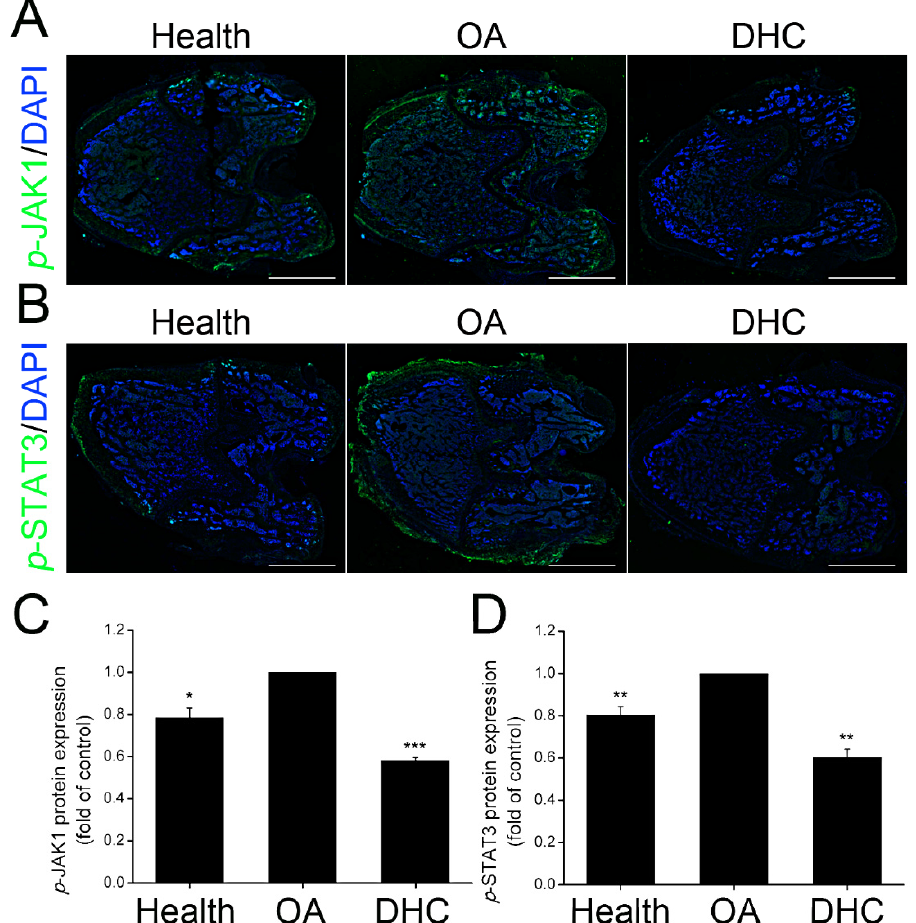
Figure 7. Dehydrocorydaline (DHC) inhibited the p -JAK1 and p-STAT3 expression in the complete anterior cruciate ligament transection (ACLT)-induced OA. Protein expression of ( A ) p-JAK1 and ( B ) p-STAT3 detected through immunofluorescence staining. The quantified results of ( C ) p-JAK1 and ( D ) p-STAT3. Scale bar = 2 mm. Data are presented as mean ± SD. *, p < 0.05; **, p < 0.01; ***, p < 0.001 compared to the OA group.